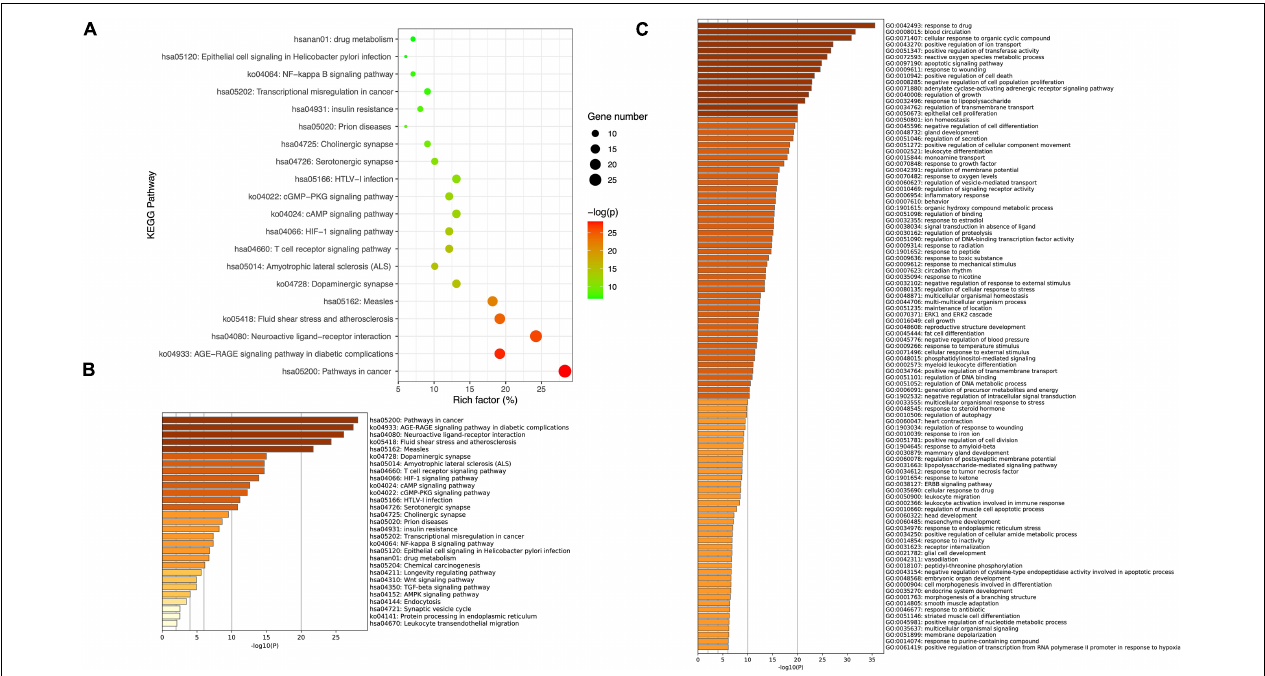
FIGURE 3 | Kyoto Encyclopedia of Genes and Genomes pathway and GO enrichment of core candidate targets of TPG against Parkinson’s disease. (A) Top 20 KEGG pathway enrichment. (B) Heatmaps of KEGG pathway enrichment of core candidate targets of TPG against Parkinson’s disease. (C) Heatmaps of GO_BP enrichment.